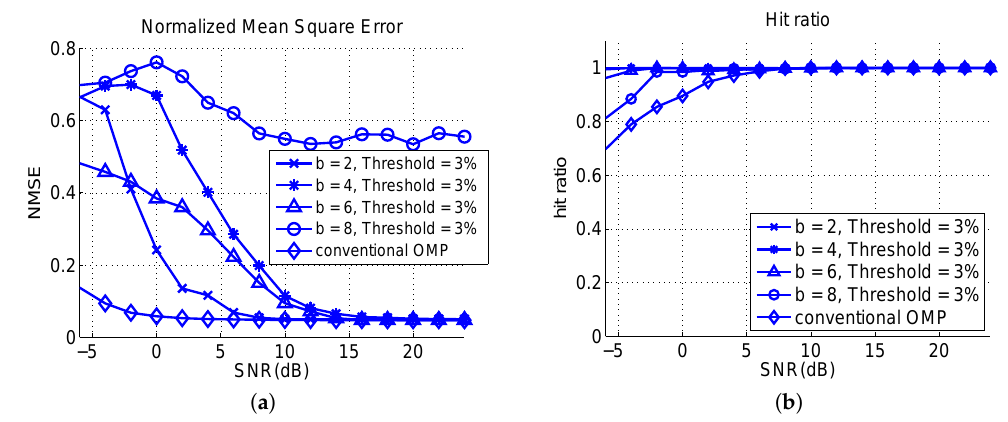
Figure 8. Analysis results of ( a ) NMSE and ( b ) hit ratio for different block sizes.